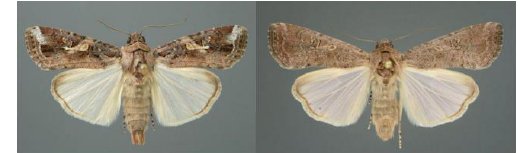
Figure 3: FAW larval identification marks (Prasanna et al., 2018)